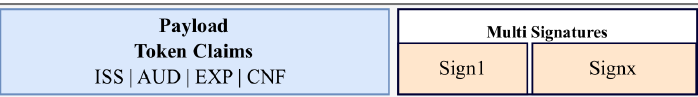
Figure 2. A COSE Proof-of-Possession token format.